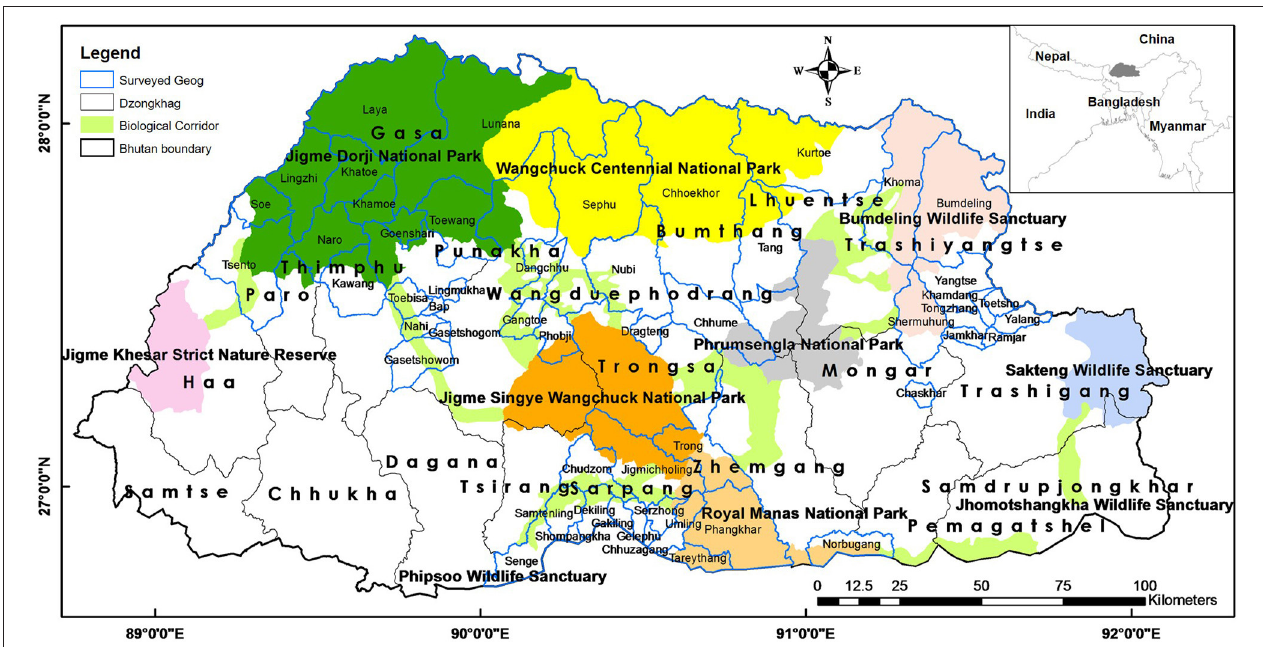
FIGURE 1 | Map of Bhutan showing 20 Dzongkhags (districts), 53 Geogs (sub-districts) where interviews were conducted, 10 protected areas, and interconnecting biological corridors. The inset shows the location of Bhutan relative to its neighboring countries in South Asia.